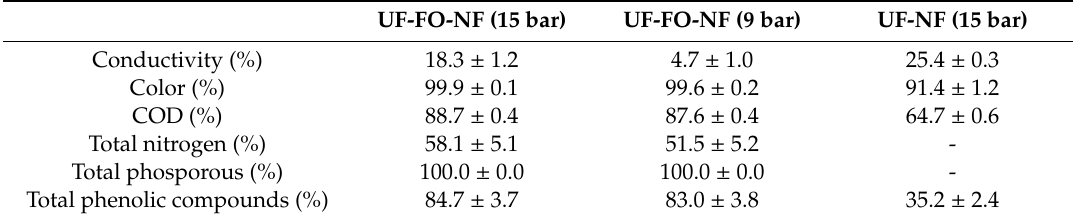
Table 2. Solutes rejection in the nanofiltration step (UF-FO-NF: the feed solution was the diluted draw solution from the FO step; UF-NF: the feed solution was the UF